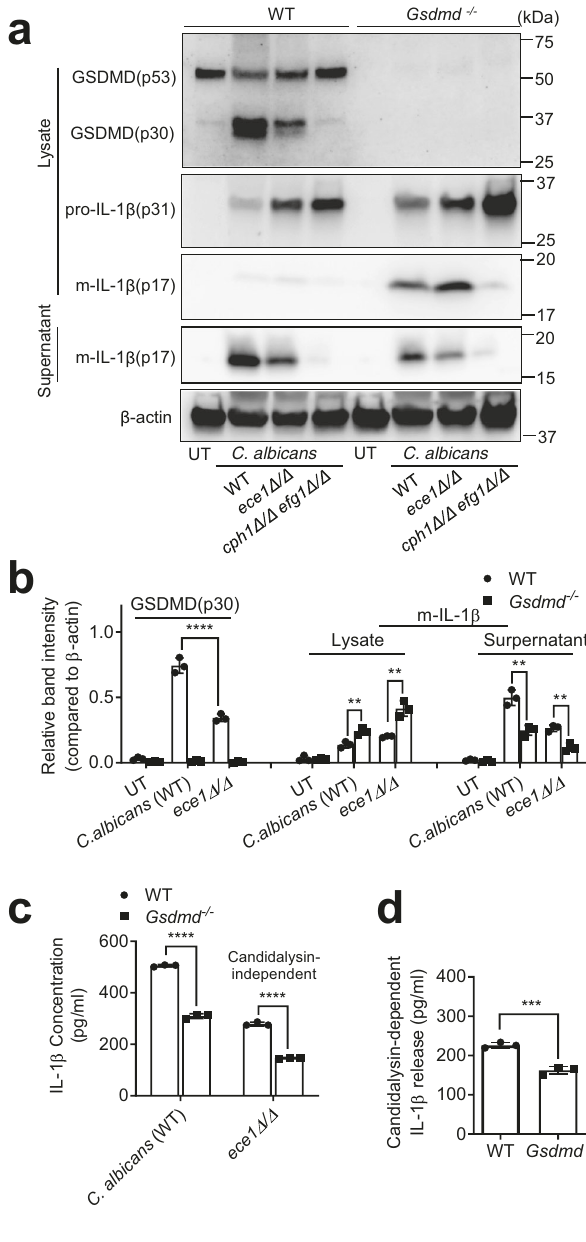
Fig. 5 GSDMD plays critical roles in both candidalysin-dependent and -independent IL-1 β secretion by C. albicans infected macrophage. a , b C. albicans triggered GSDMD cleavage via both candidalysin-dependent and -independent mechanisms. a C. albicans- triggered GSDMD cleavage and IL- 1 β production. BMDMs from WT and Gsdmd -/- mice were infected with WT or candidalysin-de fi cient ( ece1 Δ / Δ ) C. albicans for 6 h at MOI 50. GSDMD (cleaved p30 and full-length p53), pro-IL-1 β , and mature IL-1 β (m-IL-1 β ) in the cell lysates and m-IL-1 β in the supernatants were assessed by western blotting. Results are representative of data from three biological replicates. Source data are provided as a Source Data fi le. b The intensities of protein bands were quanti fi ed using ImageJ. Two-tailed unpaired Student ’ s t test was used for statistical comparisons. Data shown are means ± SD (n = 3 biologically independent samples per group). p < 0.0001 (GSDMD p30),